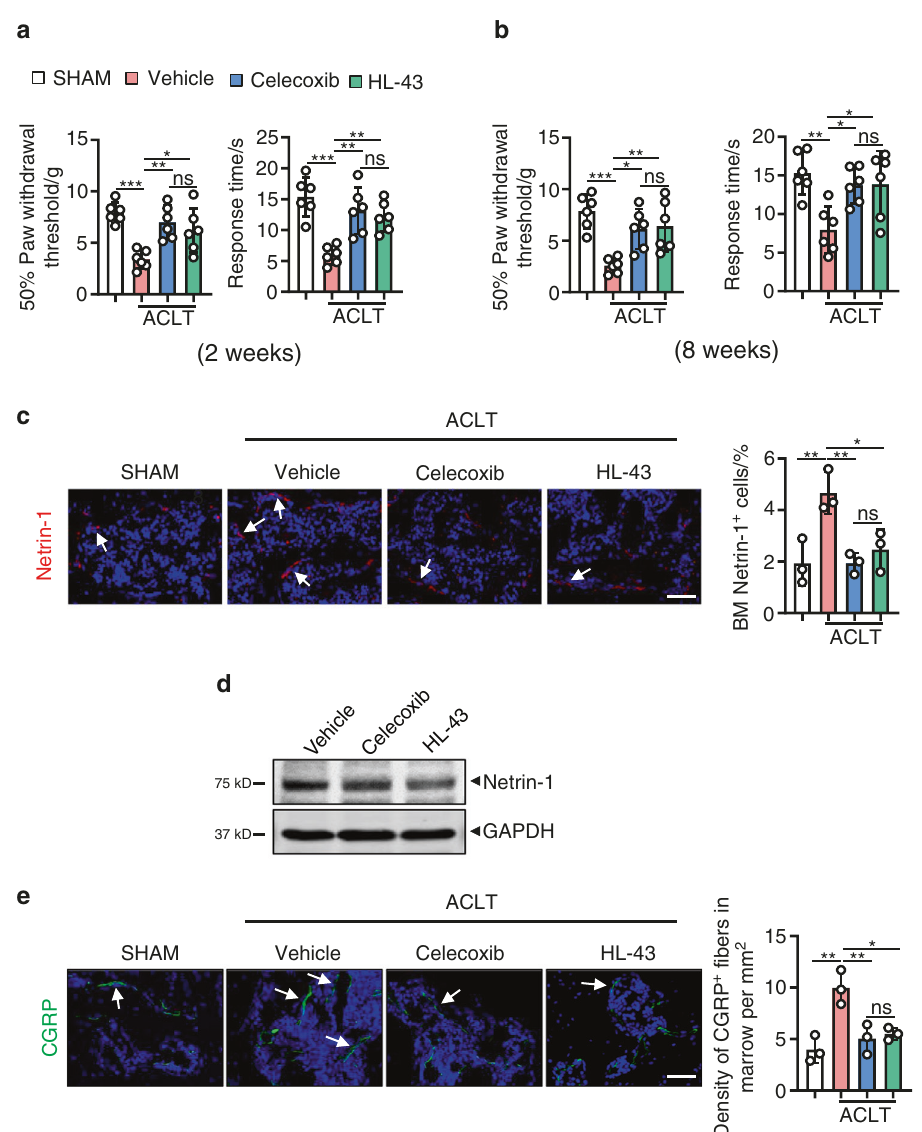
Fig. 6 HL-43 reduces pain in OA by suppressing Netrin-1 secretion by osteoclasts and CGRP-positive sensory neuron recruitment to subchondral bone. Von Frey assay and thermal hyperalgesia test conducted at the right hind paw of the WT mice treated with celecoxib (30 mg·kg − 1 ) or HL-43 (30 mg·kg − 1 ) for 2 weeks ( a ) or 8 weeks ( b ) after ACLT surgery. Error bars are the mean ± s.d. ** P < 0.01 and *** P < 0.001, ns, not signi fi cant by one-way ANOVA followed by Tukey ’ s t tests. n = 6 for each group. c Representative images of IHF staining of Netrin-1 (red) in the subchondral bone of the WT mice orally treated with celecoxib (30 mg·kg − 1 ) or HL-43 (30 mg·kg − 1 ) 2 weeks post-ACLT surgery (left) and quantitative analysis (right). The white arrows indicate Netrin-1 IHF signals. Error bars are the mean ± s.d. * P < 0.05, ** P < 0.01 and *** P < 0.001, ns, not signi fi cant by one-way ANOVA followed by Tukey ’ s t tests. n = 3 for each group. Scale bars, 20 μ m. d Representative images of Netrin-1 protein expression by western blotting for osteoclasts generated using BMMs from WT mice stimulated with 10 ng·mL − 1 M-CSF and 50 ng·mL − 1 RANKL. The cells were incubated with 100 nmol·L − 1 PGE2 with or without celecoxib (10 μ mol·L − 1 ) or HL-43 (10 μ mol·L − 1 ) for 5 days. The experiments were performed with three biological replicates. e Representative images of IHF staining of CGRP- positive sensory nerve fi bers (red) in the subchondral bone of the WT mice orally treated with celecoxib (30 mg·kg − 1 ) or HL-43 (30 mg·kg − 1 ) 2 weeks post-ACLT surgery (left) and quantitative analysis (right). The white arrows indicate CGRP IHF signals. Error bars are the mean ± s.d. ** P < 0.01 and *** P < 0.001, ns, not signi fi cant by one-way ANOVA followed by Tukey ’ s t tests. n = 3 for each group. Scale bars, 20 μ subchondral bone osteoclasts following activation of EP4 via speci fi cally osteoclast function, remains unclear. Here, we PGE2. Finally, we identi fi ed HL-43 as a candidate small observed elevated expression of the PGE2 receptor EP4 in molecule for the treatment of OA; these molecules had better osteoclasts from subchondral bone. Genetic deletion of the EP4 ef fi cacy in improving subchondral bone microarchitecture than receptor in osteoclasts or using a speci fi c inhibitor reduced OA celecoxib (clinically approved COX-2 inhibitor) and fewer side progression in a murine model. Furthermore, this effect was effects. accompanied by lower recruitment of type H blood vessels and While PGE2 is a known regulator of bone homeostasis, the CGRP-positive sensory neurons in the subchondral bone, with direct effects of PGE2 on osteoclast activity remain controversial, implications for disease progression and pain. We also with studies showing both stimulatory and inhibitory effects 69,70 . identi fi ed the primary signaling pathway triggered in